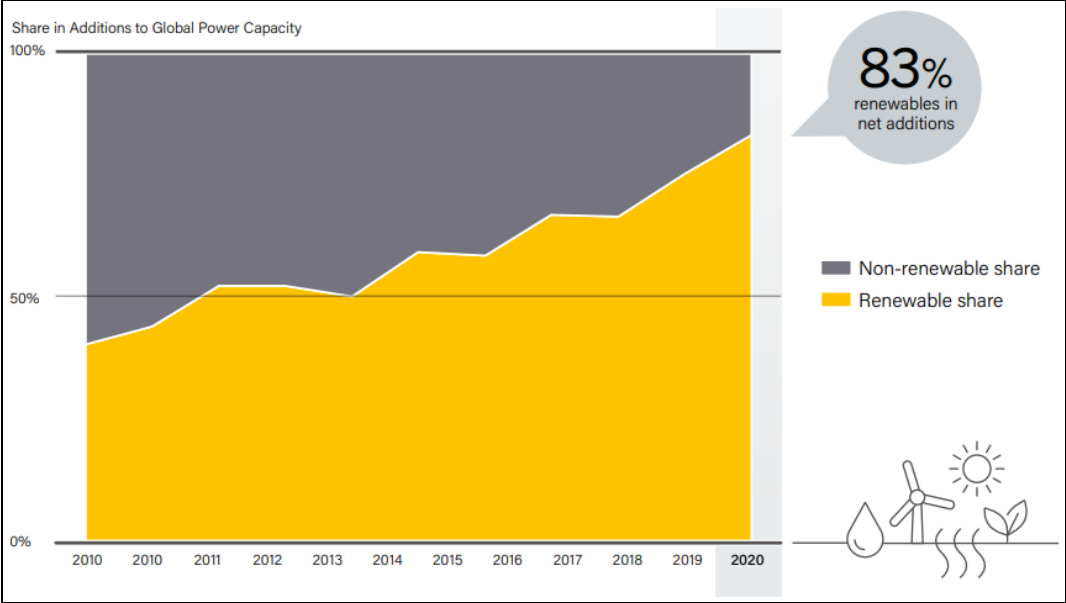
Figure 1. Shares of Net Annual Additions in Power Generating Capacity, 2010 – 2020 [8].